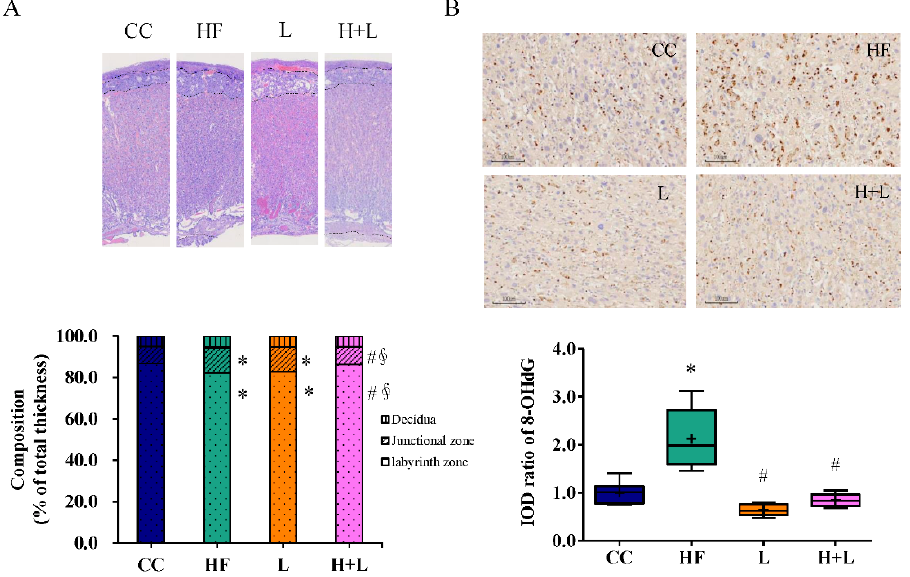
Figure 6. Histological changes in placenta with maternal high-fat diet and Lactobacillus reuteri therapy ( A ) Histological manifestations of the placenta. The mean proportions of the thickness of the decidua basalis, junctional zone, and labyrinth zone are shown. ( B ) Oxidative stress was determined by 8-hydroxy-2-deoxyguanosine (8-OHdG) staining. * Compared to the CC group, p < 0.05; # compared to the HF group, p < 0.05; ∮ compared to the L group, p < 0.05. CC, maternal control diet group; HF, maternal high-fat diet group; L, maternal control diet with prenatal Lactobacillus reuteri treatment; H + L, maternal high-fat diet with prenatal Lactobacillus reuteri treatment; IOD, image optical density. The diagram shows the mean level (cross symbol) “+”.